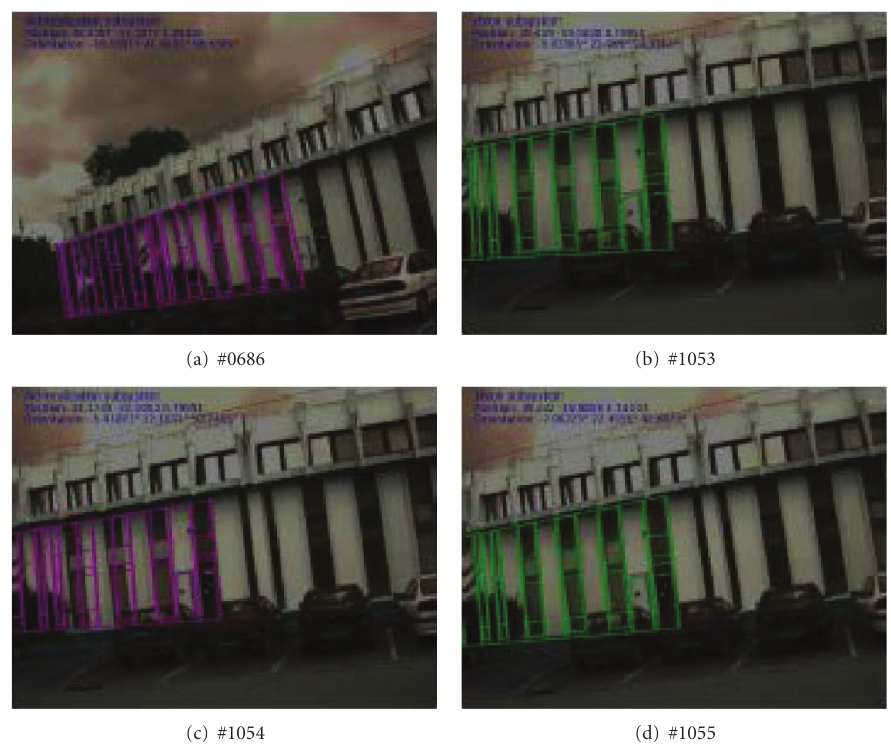
Figure 15: Registration of the 3D model using the poses obtained with our hybrid system.